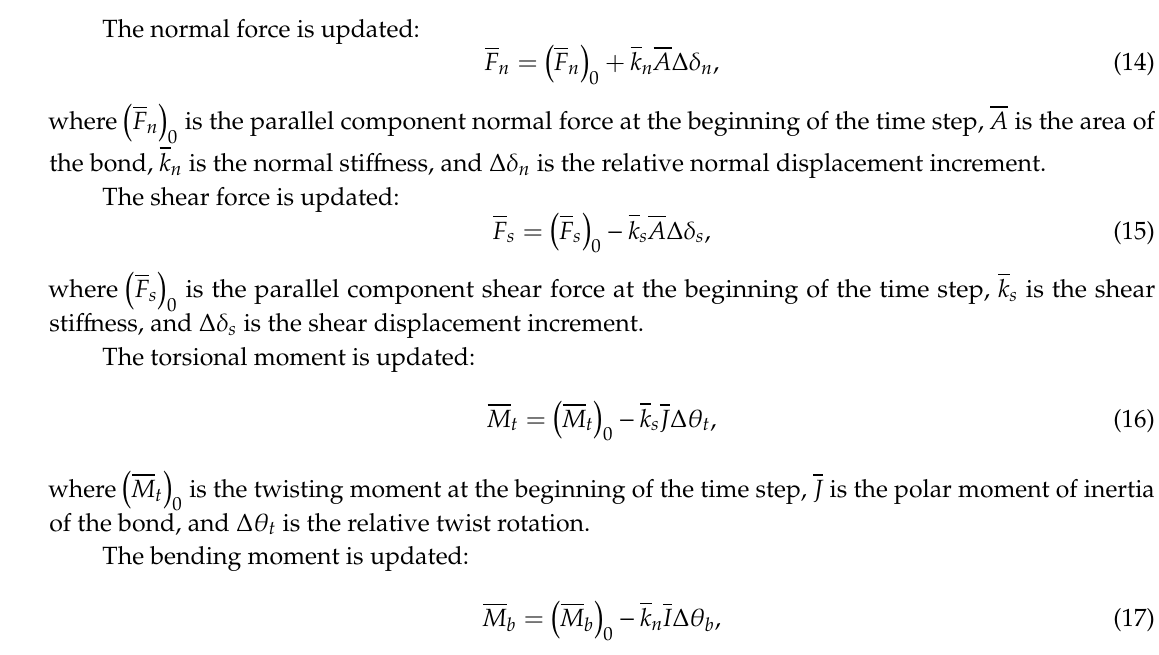
Figure 5. Illustration of the linear parallel contact model.